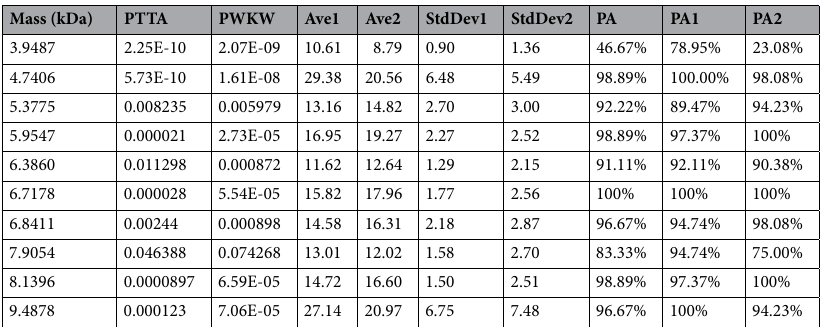
Table 1. Peak statistic report. PTTA is the p -value of Welch ‘s t -test; PKWK is the p -value of Wilcoxon test; index 1 refers to class responsive; index 2 refers to class unresponsive; Ave is the overall intensity average; Ave1 is the intensity average of class responsive; Ave2 is the intensity average of class unresponsive; StdDev is the overall intensity standard deviation; StdDev1 is the intensity standard deviation of class responsive; StdDev2 is the intensity standard deviation of class unresponsive; PA is the overall proportion of appearance; PA1 is the proportion of appearance of class responsive; PA2 is the proportion of appearance of class unresponsive.